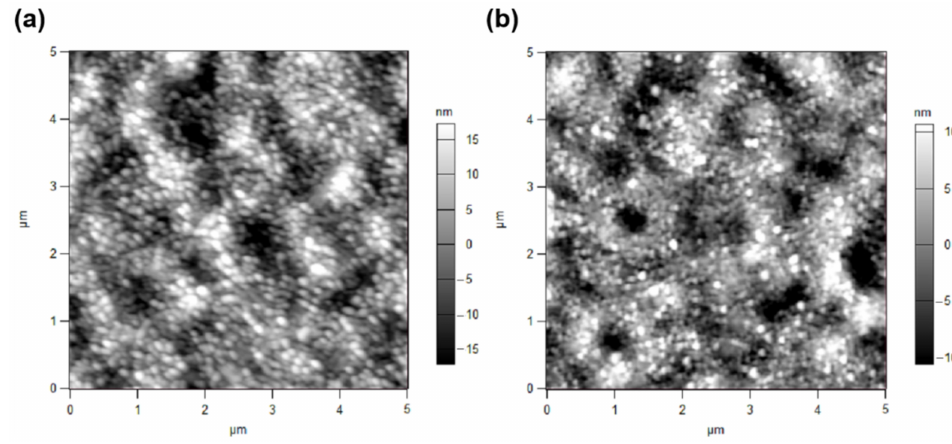
Figure 2. The surface micrographs of all thin films ( a ) BLT, ( b ) 0.4BNT0.6BLT.